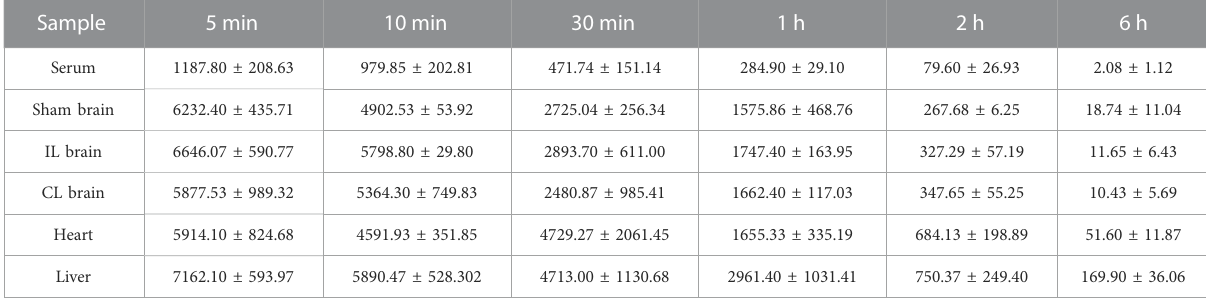
TABLE 1 Distribution of TJ-5 in tissues during the different time points (ng/ml or ng/g, mean ± SD).